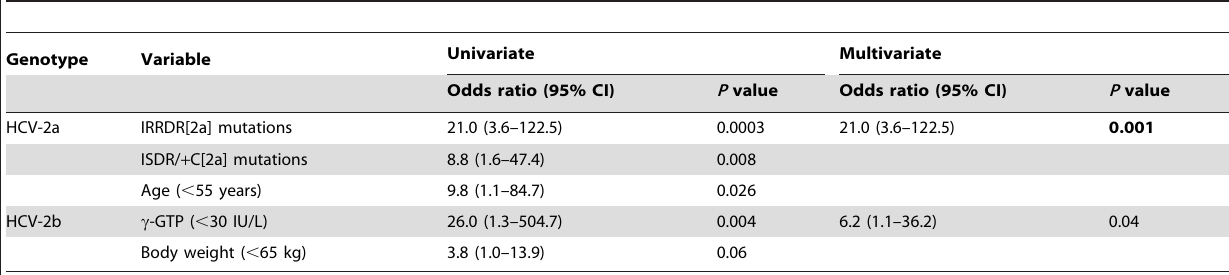
Table 5. Univariate and multivariate analyses for identification of independent predictive factors for SVR in HCV-2a- and -2b- infected patients treated with PEG-IFN/RBV